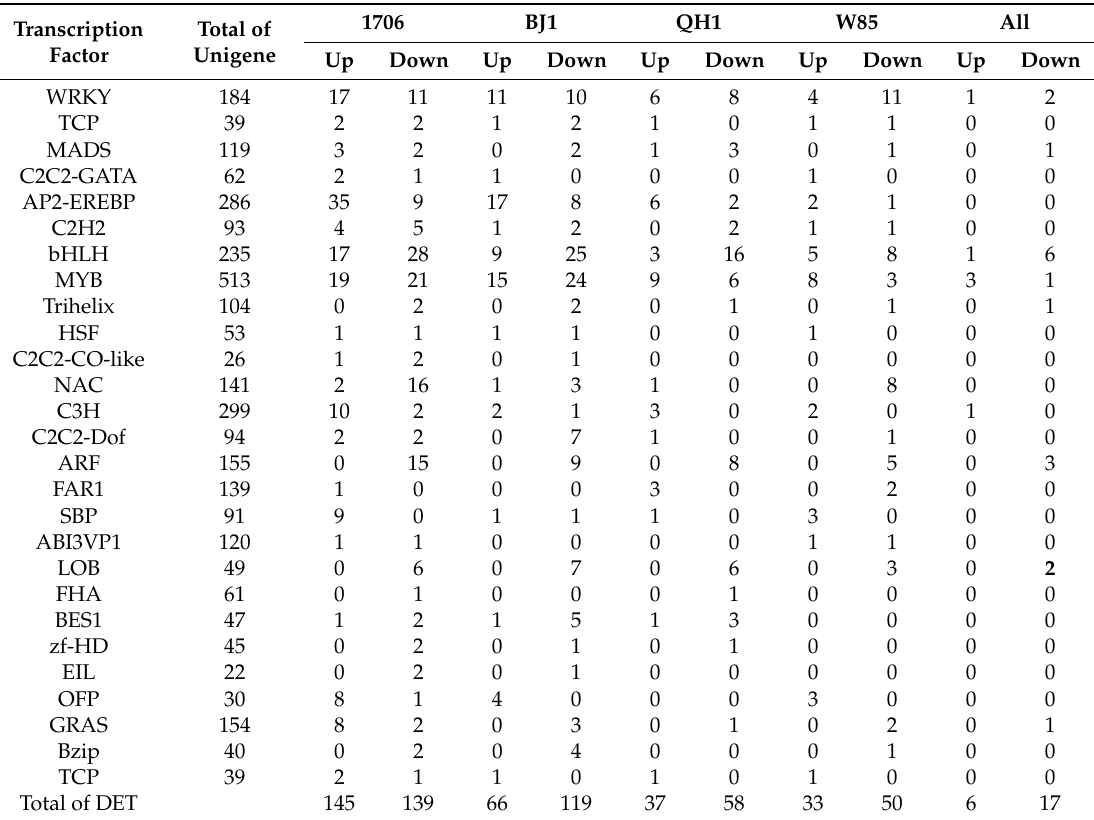
Table 2. Regulated transcription factors (TFs) between radial striation and non-radial striation in four R. glutinosa